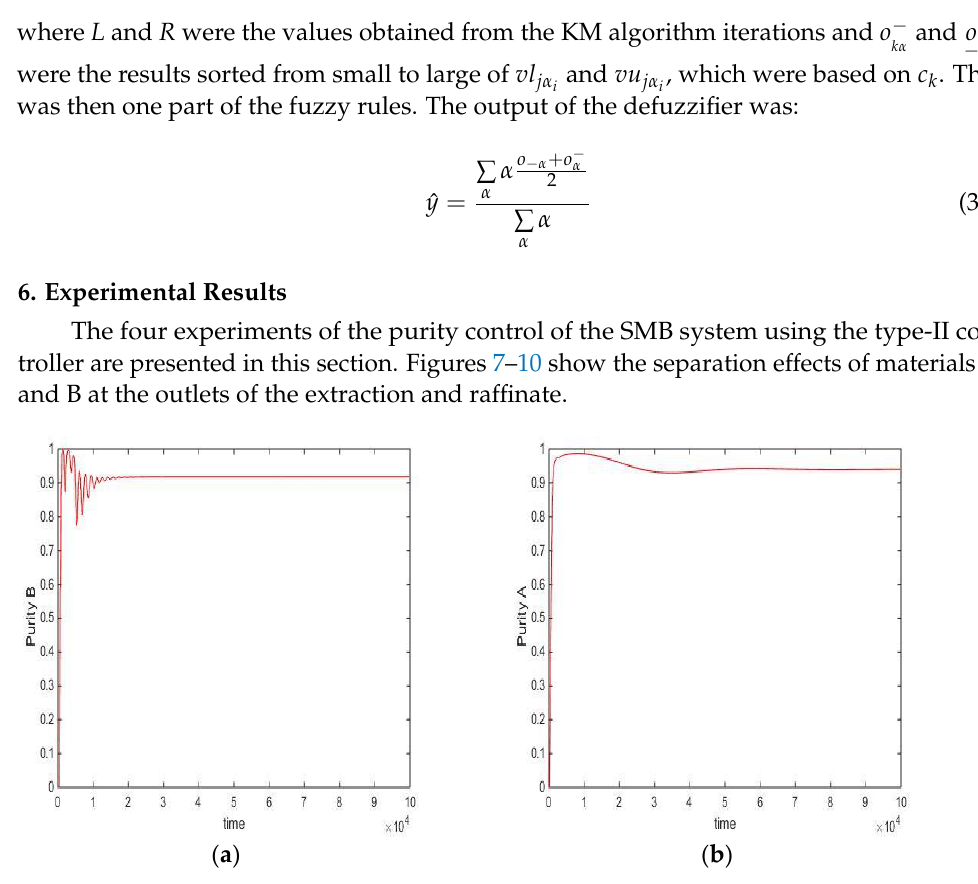
Figure 9. Control results of the third experiment (switch time = 180 s; desired A = 94%, desired B = 96%). ( a ) Extraction outlet (material B); ( b ) raffinate outlet (material A).